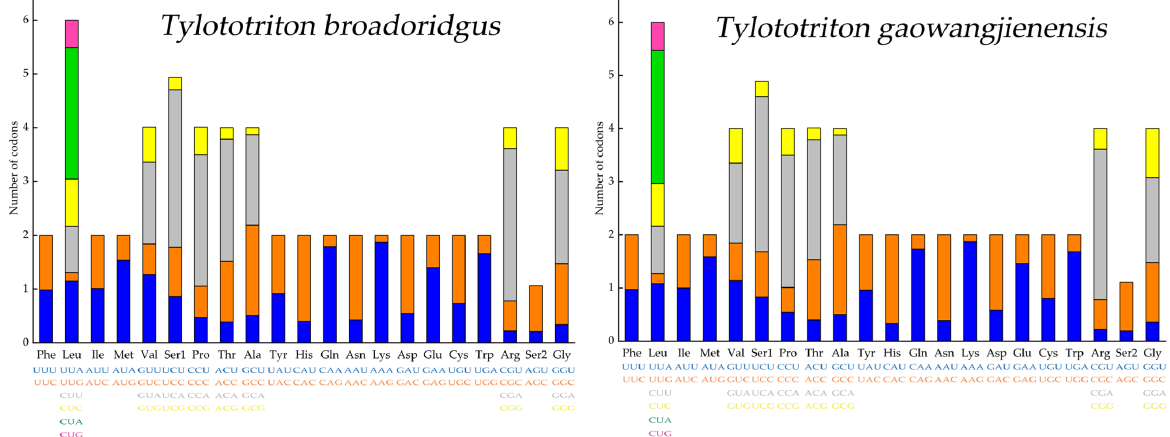
Figure 3. Relative Synonymous Codon Usage (RSCU) of mitogenomes of T. broadoridgus and T. gaowangjienensis .